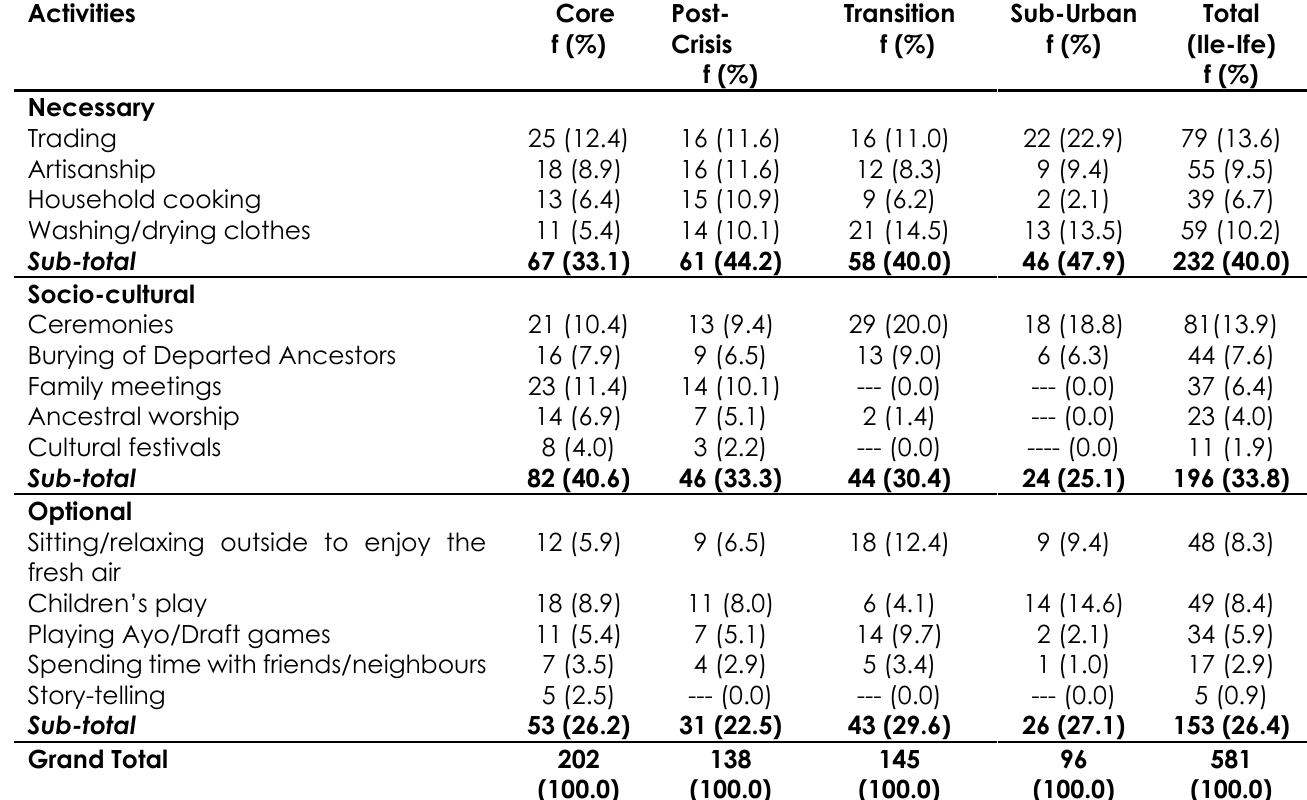
Table 3. Uses of marginal open space along the streets in the different residential areas.